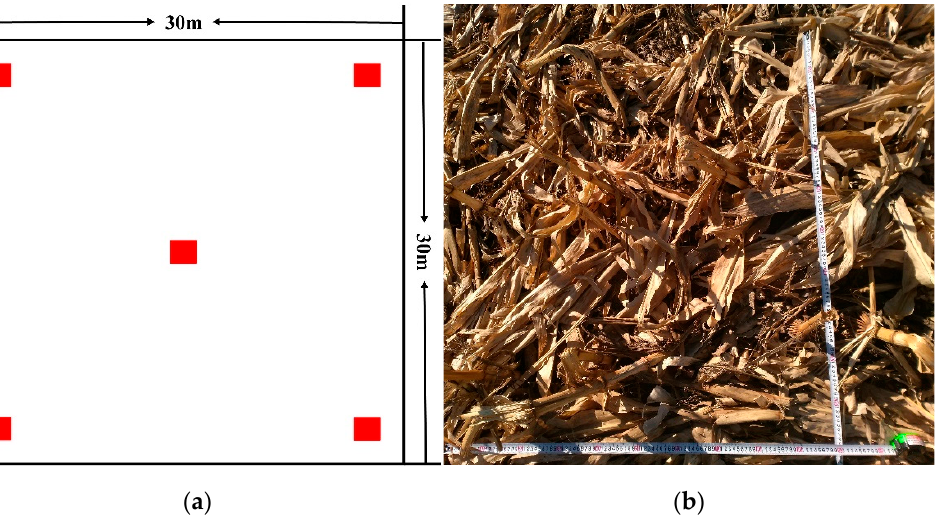
Figure 2. The basic sample unit (30 m × 30 m) ( a ), and the measurement of CRC for each subplot (1 m × 1 m) ( b ).